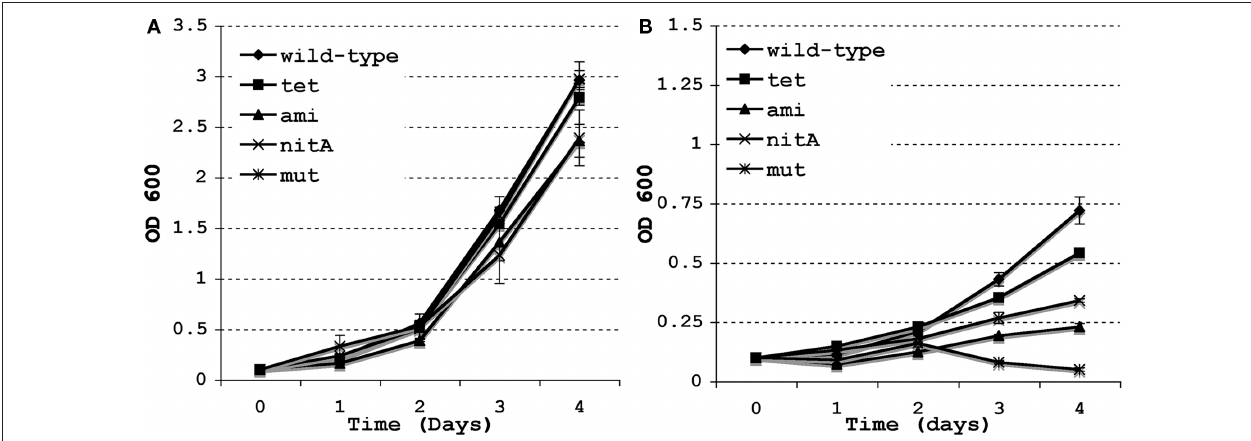
FiguRe 2 | growth of M. tuberculosis lys X strains and the effect of Polymyxin B. The M. tuberculosis wild type (WT), lys X mutant (mut), and the lys X Pami (ami), lys X Ptet (tet), and lys X Pnit A (nitA) complement strains were grown in media alone (A) and in media supplemented with Polymyxin B 500 units/mL (B) ; optical density measured at 24 h intervals. All values are the means ± SD from three independent experiments.